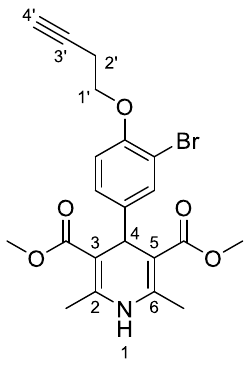
Figure 20. Chemical stucture of 3s .